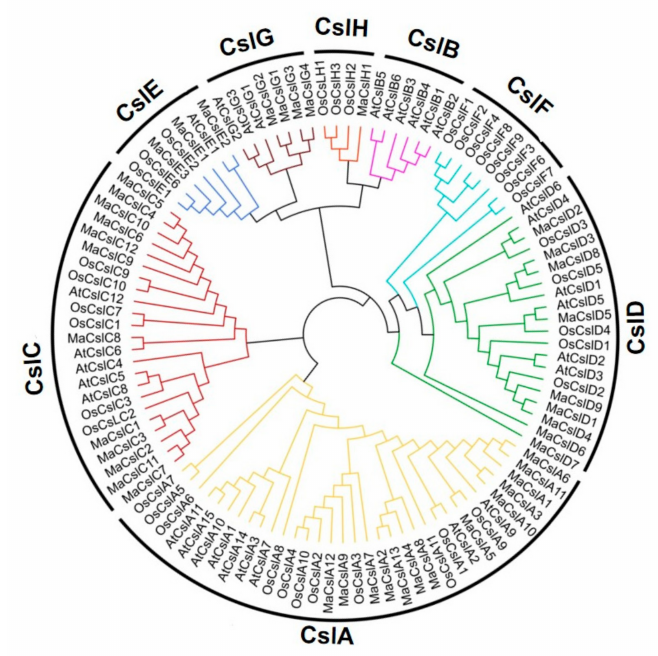
Figure 2. Phylogenetic tree of Csl proteins in banana ( Musa acuminata ), rice ( Oryza sativa ), and Arabidopsis ( Arabidopsis thaliana ). Totals 42 Csl proteins in banana, 36 in rice, and 30 in Arabidopsis were analyzed using Clustal W. Neighbor-joining trees were constructed using MEGA7.0. The bootstrap value was 1000 replicates.